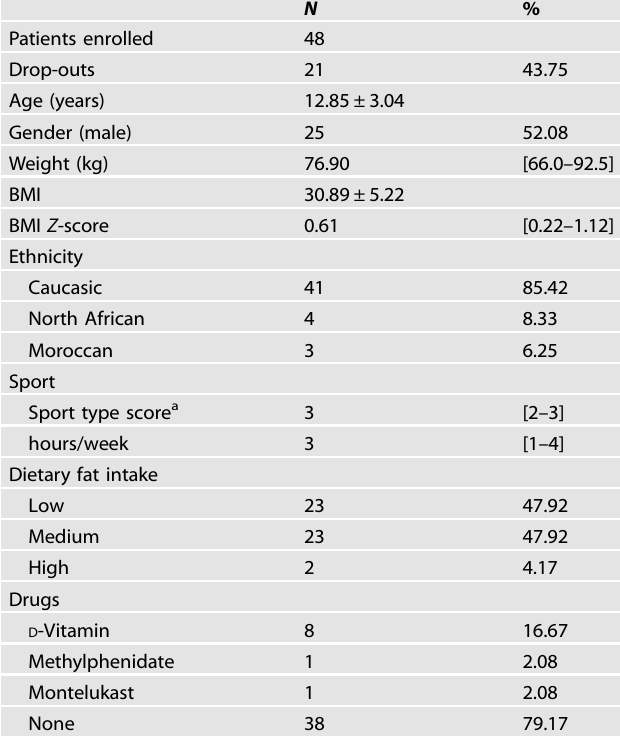
Table 1. Baseline Characterisitics of the study